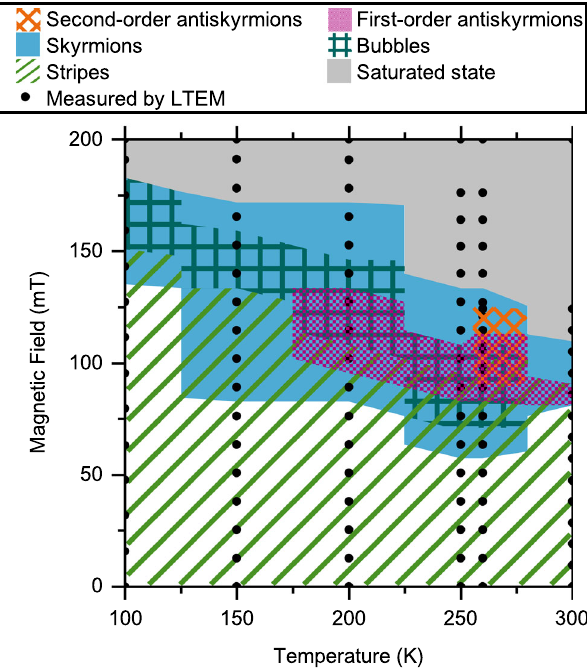
Fig. 3 Phase map of the spin objects. Magnetic fi eld and temperature dependence of the stability ranges of the different spin objects of [Fe/Ir/ Gd] 2 /[Fe/Gd] 76 /[Fe/Ir/Gd] 2 . The diagram was constructed using the data from the LTEM measurements (black points). A pure antiskyrmion phase (purple checkerboard pattern) is not observable. They always coexist with Bloch skyrmions (blue) and sometimes with stripes and/or bubbles (green stripes). The stability range of antiskyrmions is also smaller than the one of skyrmions for both temperature and fi eld. Second-order antiskyrmions were only observable at 260 K, but stayed stable for larger magnetic fi elds in comparison to fi rst-order